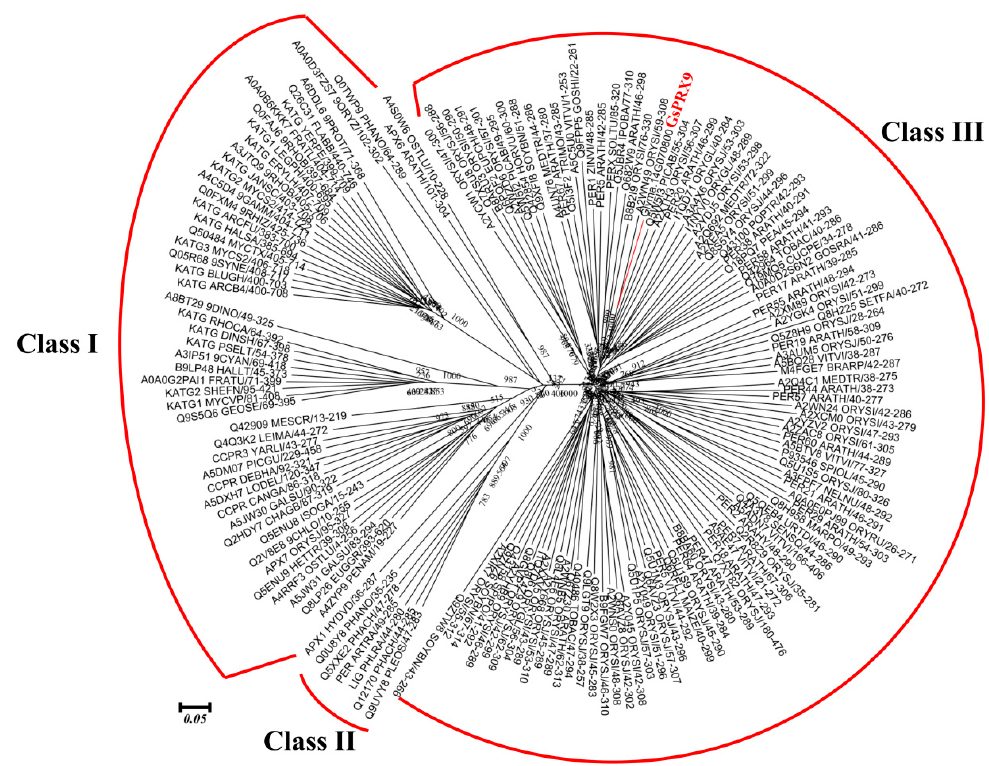
Figure 1. Phylogenetic tree of the 159 seed sequences of peroxidases superfamily and GsPRX9. The 159 seed sequences of peroxidases protein superfamily were downloaded from PFAM and the protein sequence of soybean PRX9 was downloaded from the Phytozome database. Unrooted phylogenetic tree was constructed using MEGA6.0 based on the Maximum Likelihood (ML) algorithm with 1000 bootstraps.